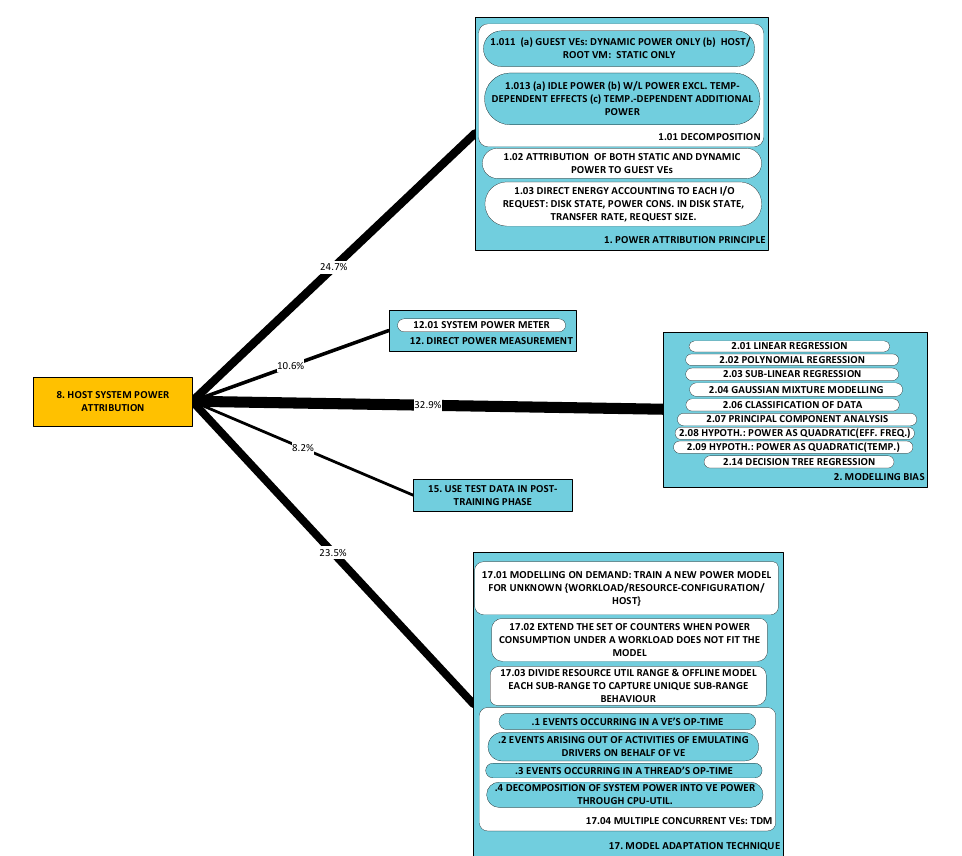
Figure 16. Approaches to solving challenges in category P8; utility metric U A is shown in line thickness and as a percentage. RUs in the respective categories are the following: P8 [57–59,61,62,69,72,